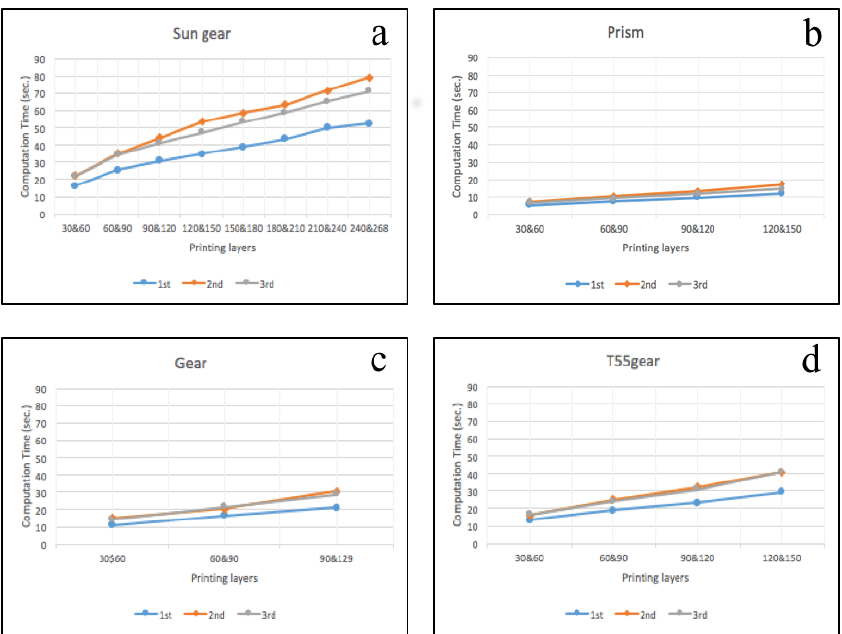
Figure 17. Image pre-processing—Non-rescale and rectification: the computation time of failure state for ( a ) sun gear; ( b ) prism; ( c ) gear; and ( d ) t55gear.